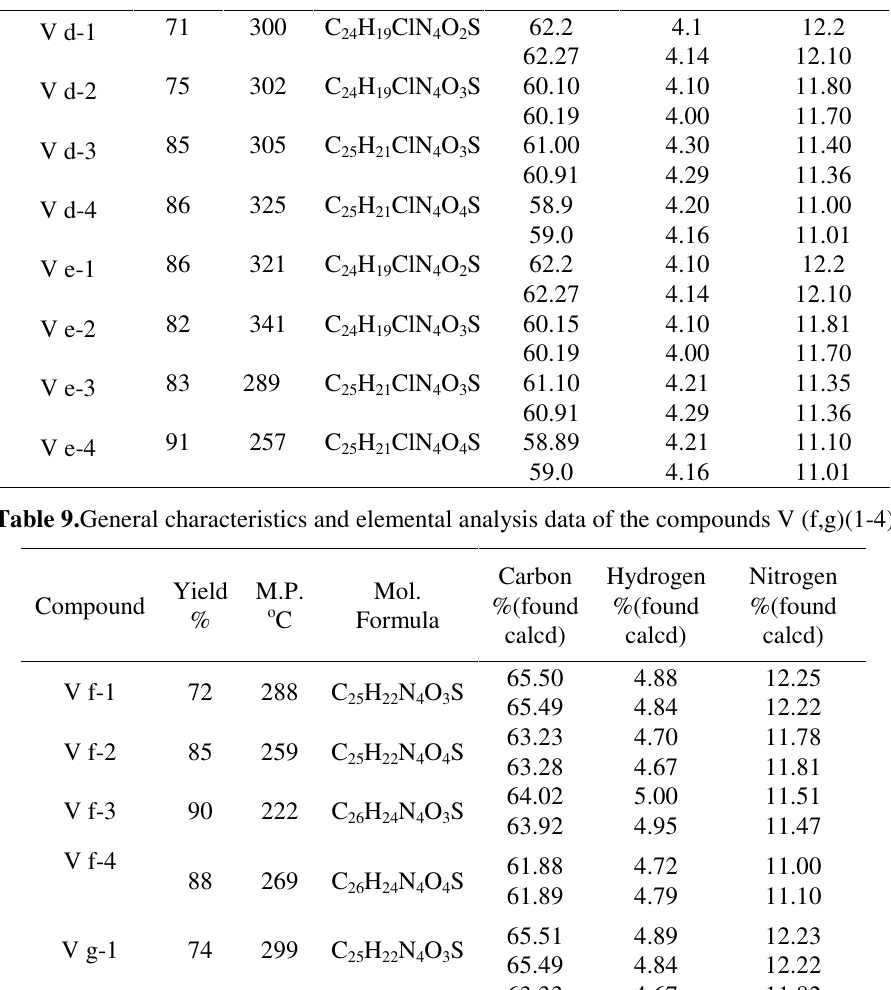
Table 9. General characteristics and elemental analysis data of the compounds V (f,g)(1-4)